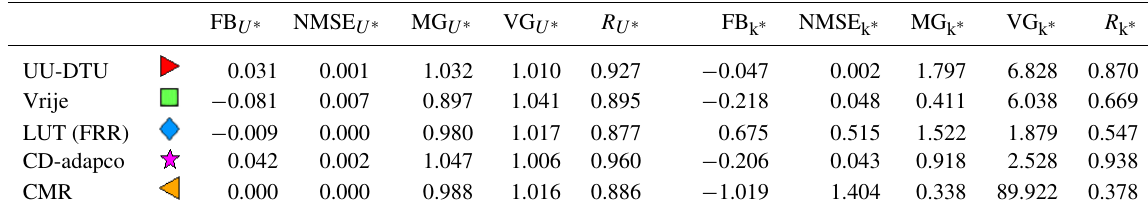
Figure 6. Normalized mean velocity U/U ref (a) and normalized turbulent kinetic energy k/U ref (b) in the wake x/D = 2.77 behind T1 measured for test case A. The upstream turbine T1 is operated at λ T1 = 6.0. The reference velocity is U ref = 11.5ms − 1 . Table 4. Statistical performance measures FB, NMSE, MG, VG and R of the normalized mean velocity U ∗ and normalized turbulent kinetic energy k ∗ predictions of the five different models for test case A. The wake flow is predicted at stream-wise measurement position x/D = 2.77 downstream of